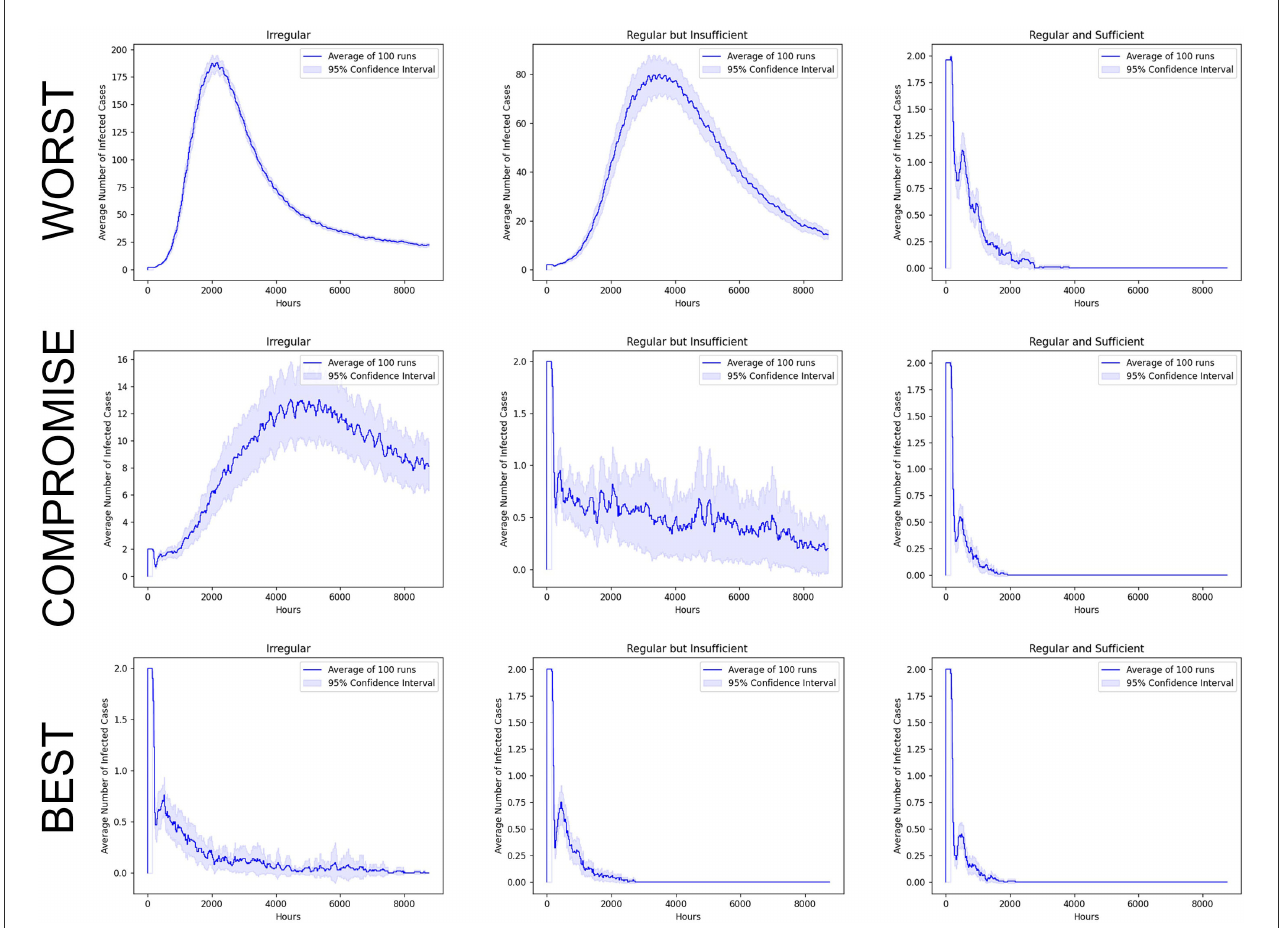
FIGURE4 One-year simulation of COVID-19 cases epidemic curve with an average of 100 simulation runs for both barangays under three different scenarios with a 95% confidence interval. Sample simulation videos for each scenario are provided as Supplementary material. The Netlogo file used in this simulation can be accessed through this GitHub link: https://github.com/PagiY/Agent-Based-Model-on-Food-Relief.git.